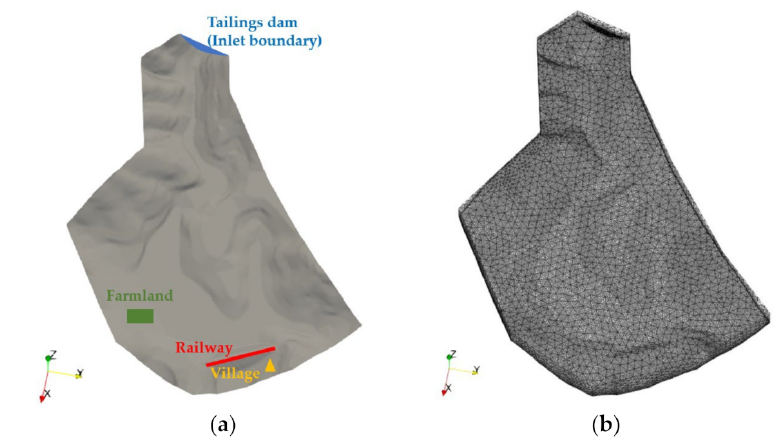
Figure 4. Diagram of the computational domain: ( a ) the geometric model; ( b ) the